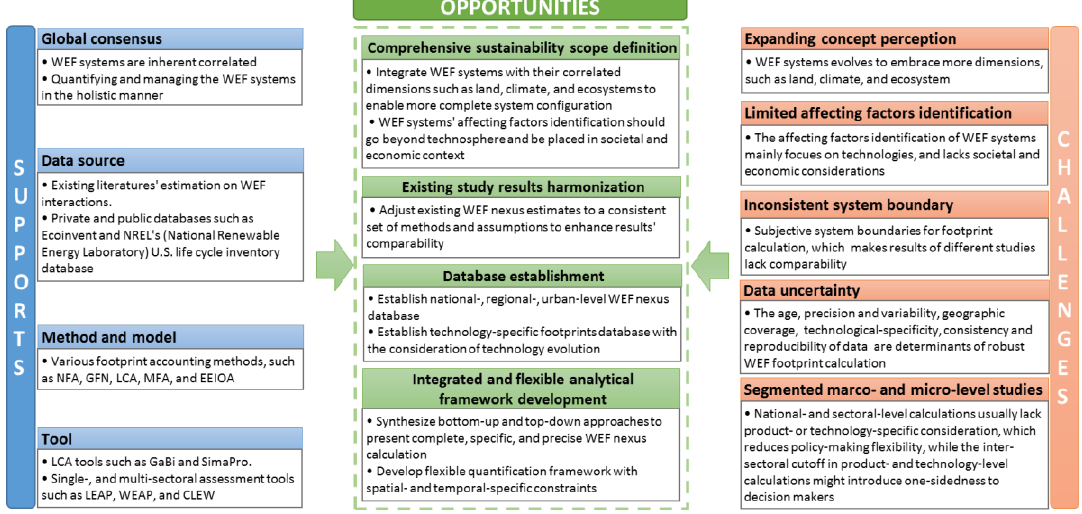
Figure 3. Methodological supports, challenges, and opportunities associated with robust WEF nexus quantification.